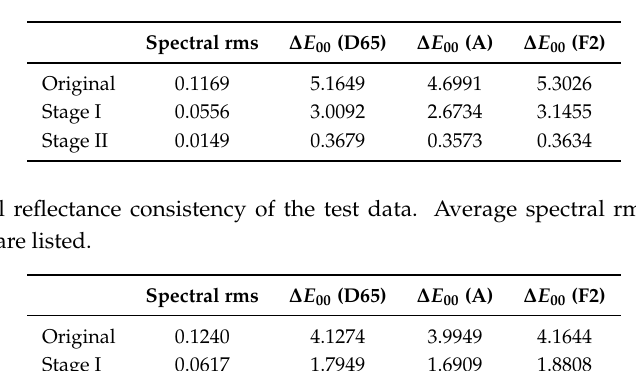
Table 4. Spectral reflectance consistency of the training data. Average spectral rms errors and color difference errors are listed.